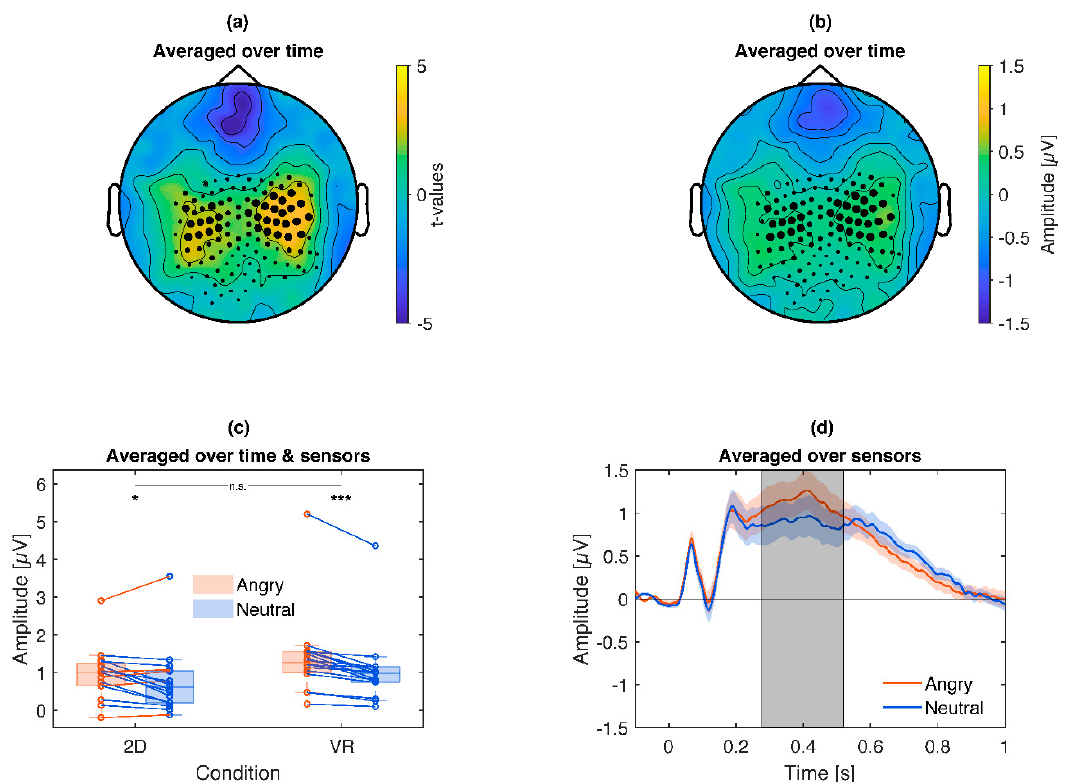
Figure 8. Illustration of the emotional modulation of the late positive potential (LPP) cluster: Angry pictures lead to an enhanced LPP compared to neutral pictures. ( a ): Topography of t -values averaged across the significant time points. The size of the marked sensors is displayed proportional to their contribution to the cluster. ( b ): Topography of the scalp potential di ff erence. The size of the marked sensors is displayed proportional to their contribution to the cluster. ( c ): Box plot and single subject values from the cluster. Blue lines indicate a more positive LPP for angry compared to neutral pictures, red the opposite. Asterisks illustrate the significance of exploratory post-hoc subgroup comparisons: *** p < 0.001, * p < 0.05, ns p > 0.05. ( d ): Time course of the respective LPP cluster. Colored shaded areas signify standard errors. Grey shaded areas signify the latency of the cluster.